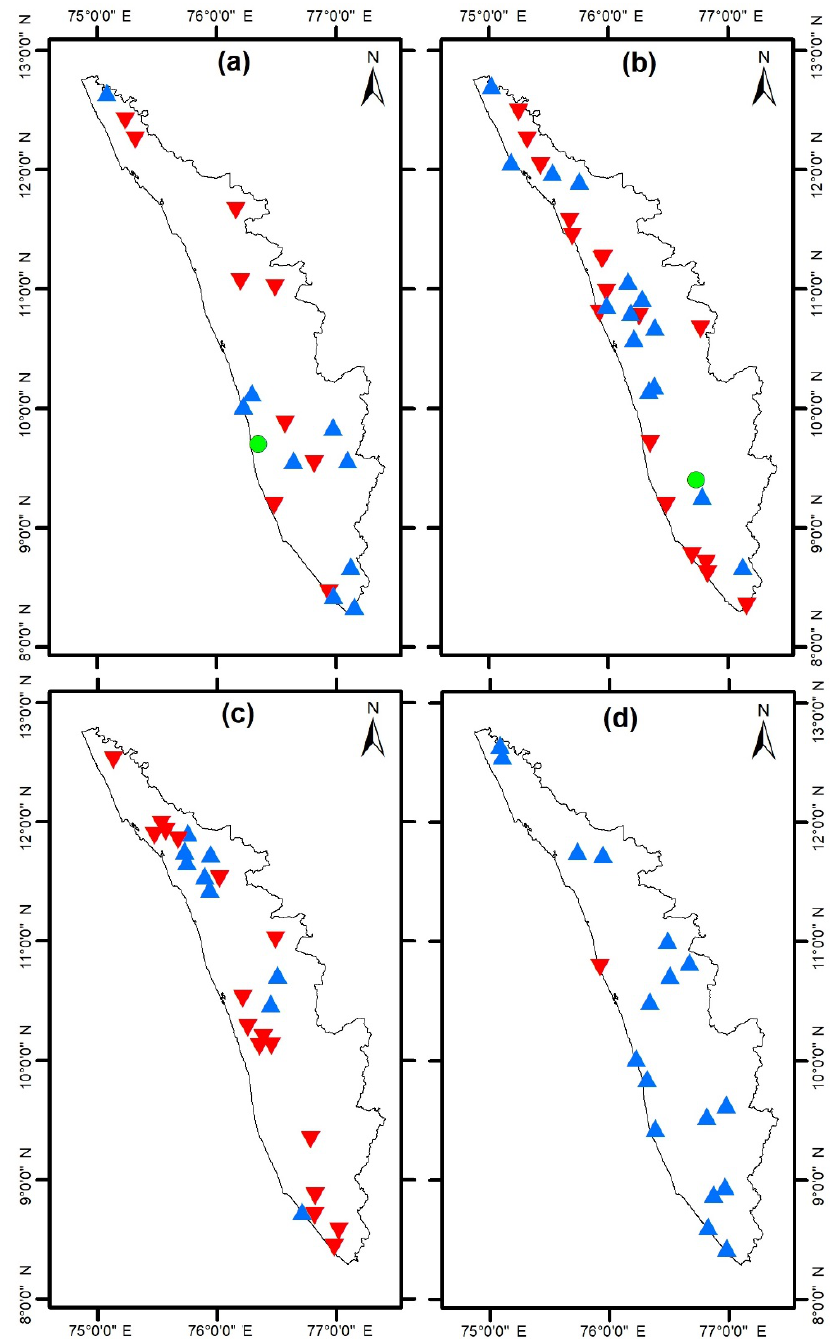
Figure 9. The positive (blue), zero (green) and negative (red) rainfall trend of locations 19-32-26-18 during ( a ) January, ( b ) April, ( c ) August, and ( d ) November. Temperature is an influential parameter to humidity and rainfall. Over the feasible locations of 19-32-26-18, an increasing temperature trend is observed in the majority of the wells. The temperature trend results are shown in Figure 10. Red triangles denote increasing temperature and reverse influence to groundwater levels. The blue triangle represents decreasing temperature, which is helpful in increasing water quantity. Out of 18 locations during the month of November, only the Ailara well location showed a decreasing trend in temperature. The results validate the global warming scenario experienced over recent